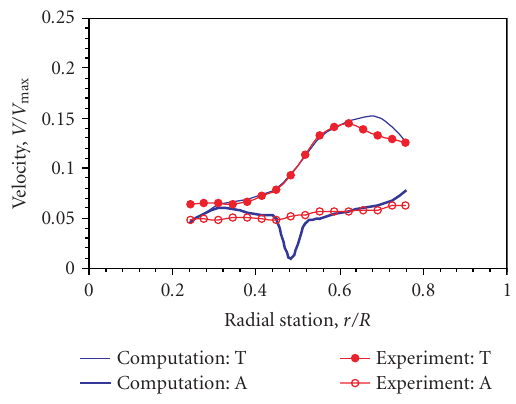
Figure 10: Comparison of computational and experimental results ( z/Z = 0 .